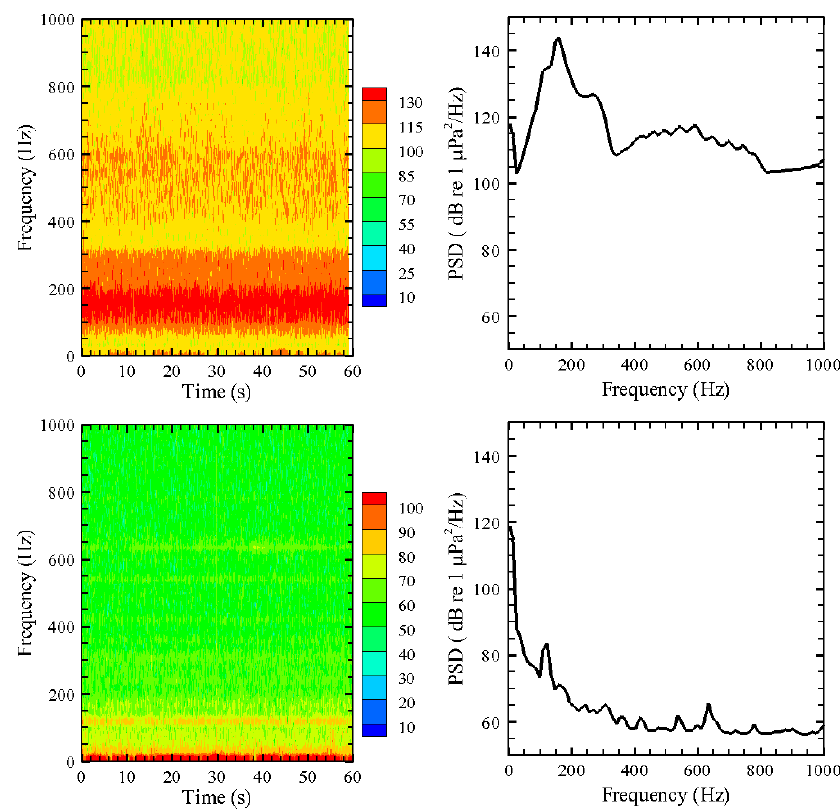
Figure 6. Spectrogram and power spectral density for exposure signal and control. Upper left: treatment 4, 1-minute spectrogram. Upper right: treatment 4, power spectral density. Bottom left: treatment control, 1-minute spectrogram. Bottom right: treatment control, power spectral